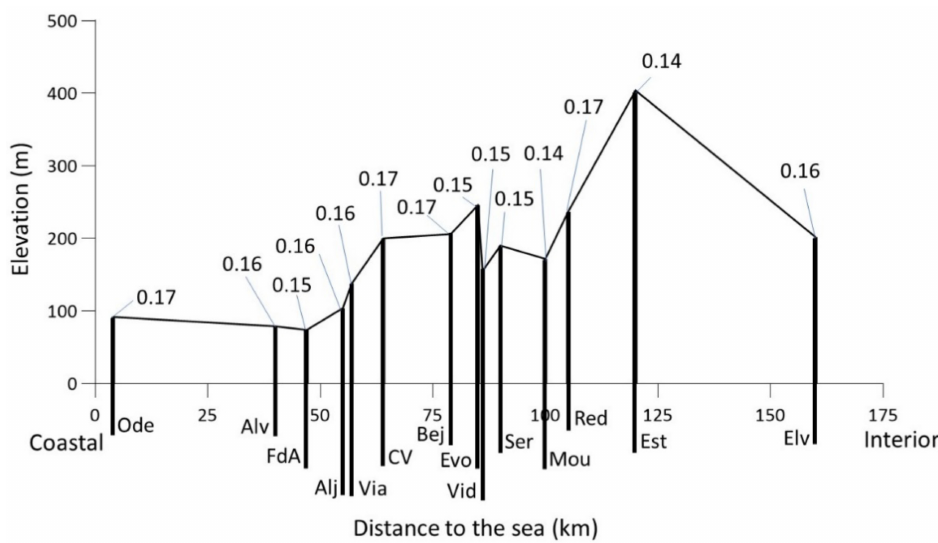
Figure 3. Calibrated and validated radiation adjustment coefficient k Rs for each longitude and land